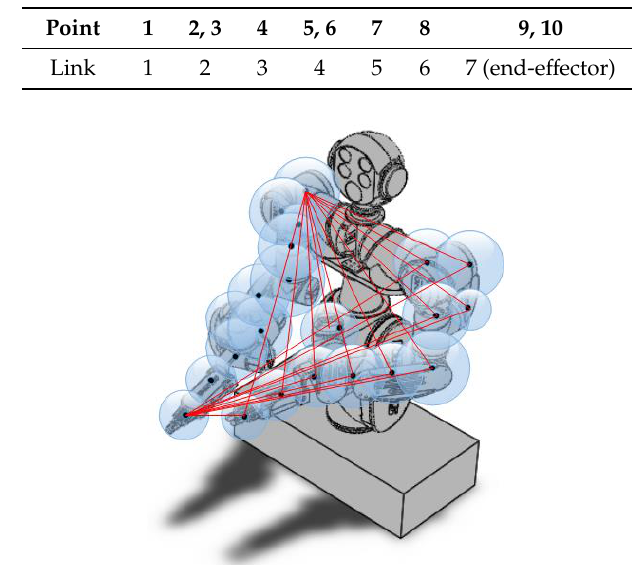
Table 2. Sphere diameters.